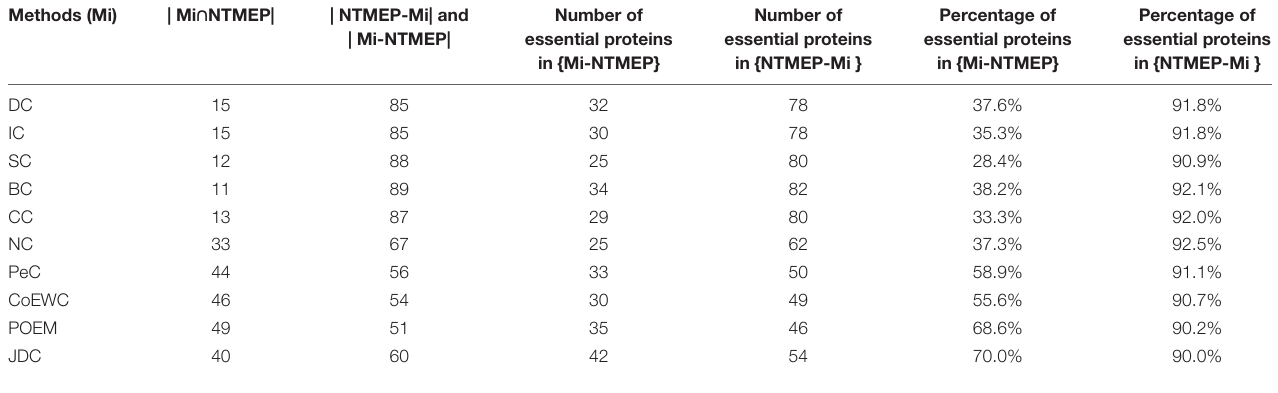
TABLE 4 | Comparison of the overlap and difference of the top 100 proteins identified by NTMEP and other 10 methods. Methods